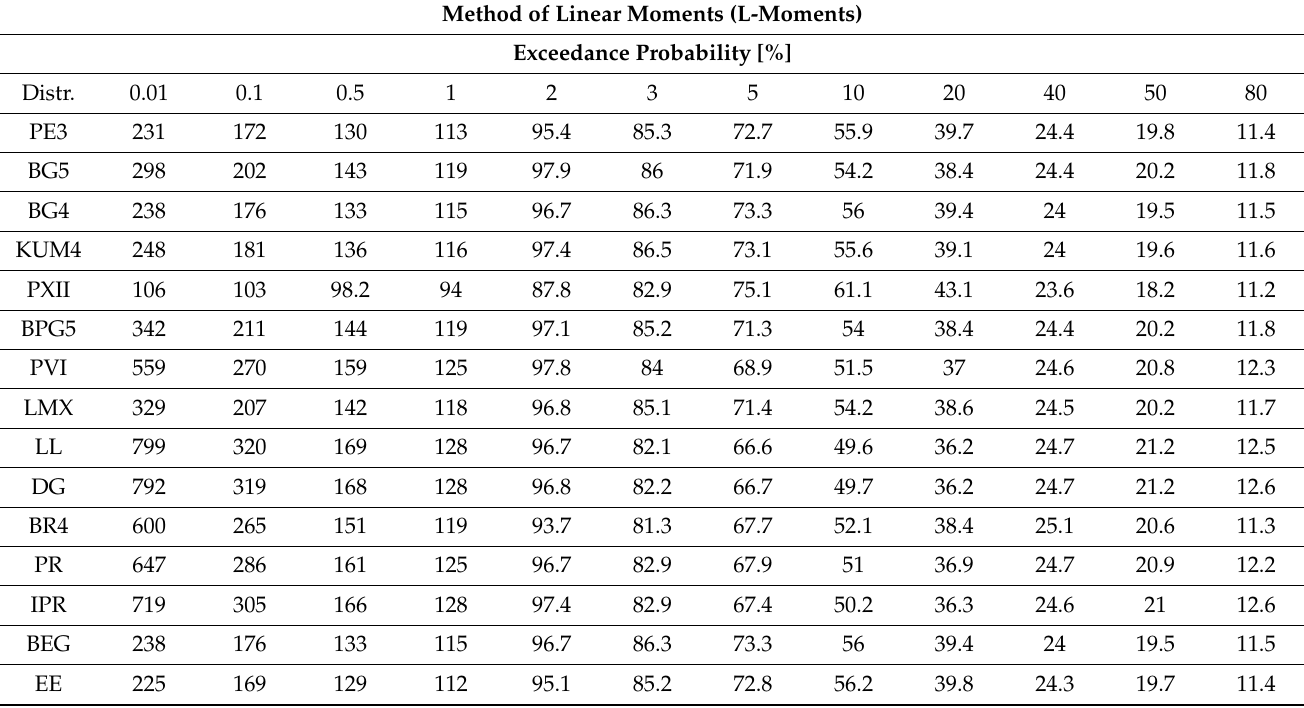
Table 6. Quantile results of the analyzed distributions for L-moments. Method of Linear Moments